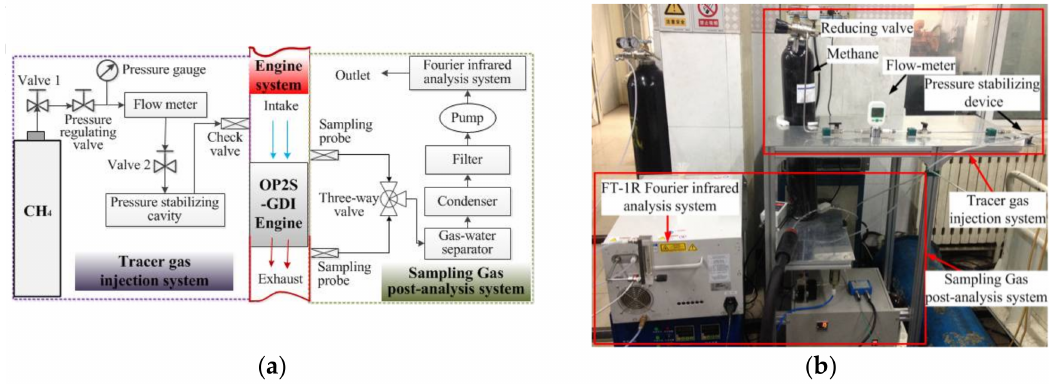
Figure 7. Tracer gas method. ( a ) Test principle; ( b ) Test